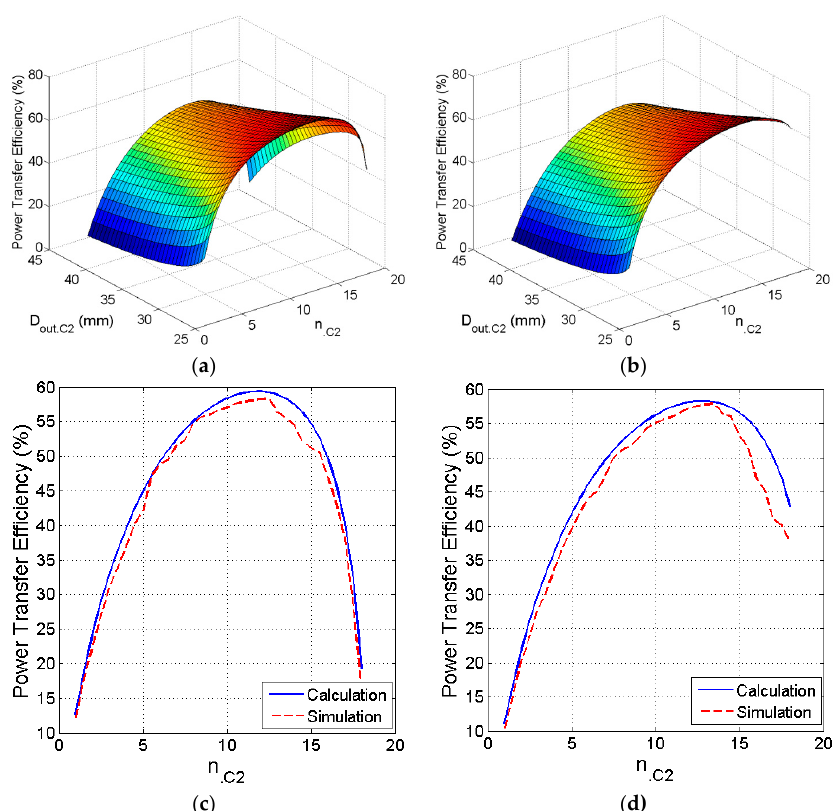
Figure 9. Optimization of the size and number of turns of the primary PSC. ( a ) Efficiency versus outer diameter versus number of turns of the square coil; ( b ) Efficiency versus outer diameter versus number of turns of the circular coil; ( c ) Calculated and simulated efficiency versus number of turns of the square coil; ( d ) Calculated and simulated efficiency versus number of turns of the circular coil.